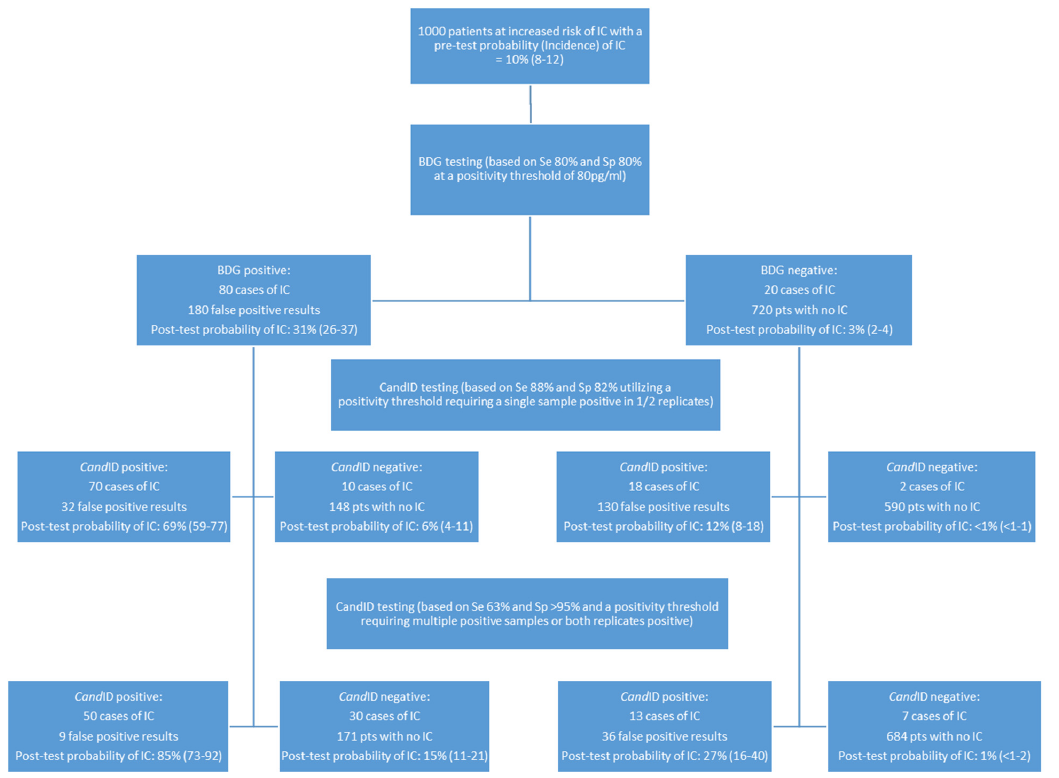
Figure 2. A classification and regression tree (CART) algorithm incorporating Fungitell (1-3)- β -D- Glucan (BDG) and OLM Cand ID real-time PCR testing for predicting invasive candidiasis (IC) in patients at increased risk of IC (incidence 10%), based on clinical prediction models for candidemia or patients post emergency surgery for intra-abdominal infection or with colonic perforation, as defined by Clancy and Nguyen [9]. The probability of IC is provided together with the 95% interval in parentheses. Sensitivity and specificity values for BDG testing for the diagnosis of IC are comparable with those generated by systematic review and meta-analysis of BDG testing and are in line with those used in previous predictive studies for IC [11,22,23]. Sensitivity and specificity values for Cand ID are those generated in the prospective arm of this current study when testing serum. Using BDG as a primary test of 1000 patients with an incidence of IC of 10%, the probability of IC associated with a positive and negative BDG result is 31% and 3%, re- spectively. While an increasing BDG concentration can increase the likelihood of IFD, false positivity can be associated with high BDG levels (e.g., IVIG), and, obviously, BDG true positivity indicates IFD, not just IC [24]. BDG specificity can be improved through sequen- tial positivity, but this involves additional sampling, potentially delaying diagnosis [25]. Incorporating Cand ID testing on the same serum sample potentially improves diagnostic understanding while providing species identification and minimizing delay. In patients already positive by BDG, the probability of IC in a patient who is also Cand ID positive in 1/2 replicates on a single occasion is 69%, whereas the probability of IC when the Cand ID is negative in a patient who was initially BDG negative is <1%. If a more stringent PCR positivity threshold requiring both PCR replicates to be positive is applied, then the prob- ability of IC in a BDG-positive patient is increased to 85% (Figure 2). A range of alternative commercially available Candida PCR assays is currently avail- able, although other than the T2Candida assay, clinical validation is limited [5,8]. The per- formance of Cand ID is comparable with that of other assays but does provide an increased range of species identification, particularly over the Bruker Fungiplex Candida , which has